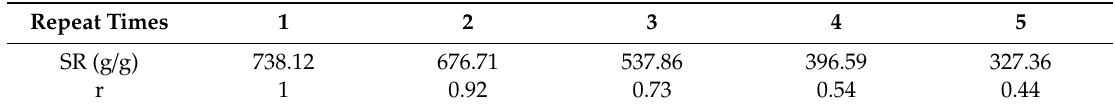
Table 2. The reusability of SW-AA-AM polymer.